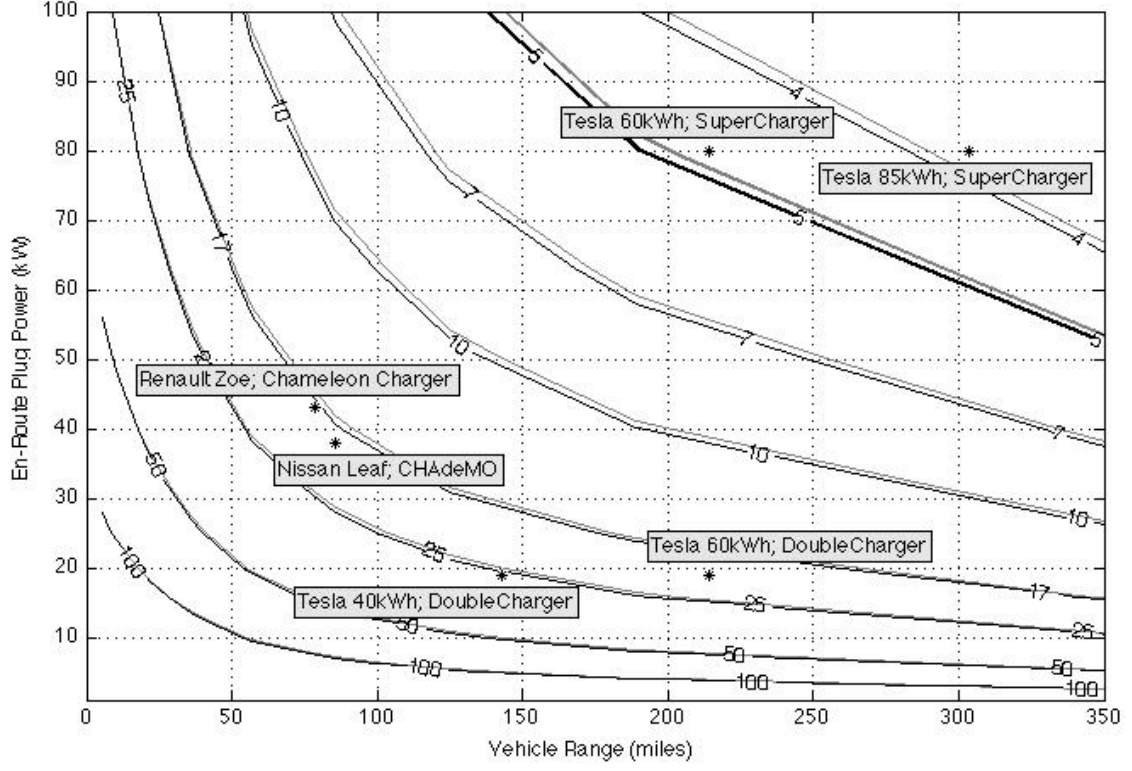
Figure 8. Time required for charging (in hours per year, labelled on each black contour line). Lines represent equal numbers of hours per year. The Y-axis gives the en route charging power (averaged over charging session), while line shading indicates two Home charging power levels—either 17 kW (black lines) or 6 kW (grey lines). Gasoline vehicles on average spend about 7 h per year for refueling (calculated in text and shown by the pair of lines third down from the top right, labeled “7”).